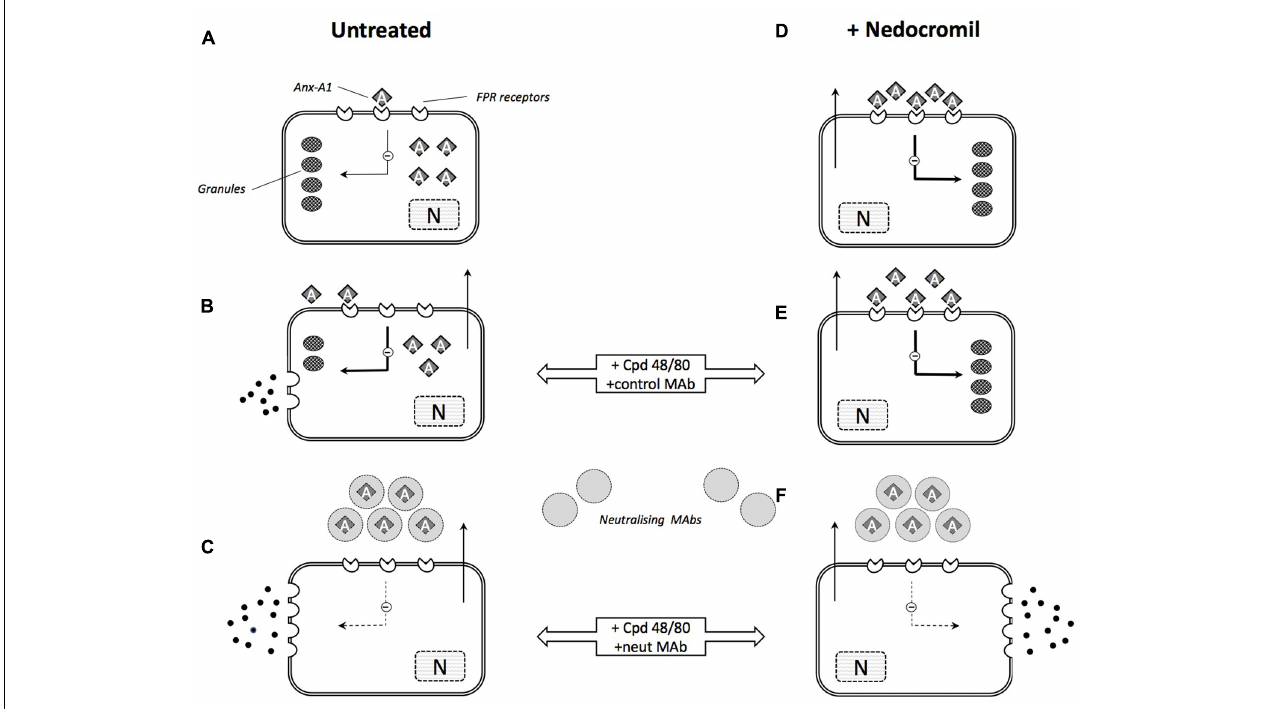
FIGURE 3 | Schematic illustration of the role of Anx-A1 in mast cell degranulation and cromone action. (A) In the untreated, ‘resting’ mast cell, there is an intracellular pool of Anx-A1, a small proportion of which is externalized exerting a low-level tonic inhibitory influence on cell activation. (B) During stimulation by (e.g., Cpd 48/80) granule contents are released but Anx-A1 is also phosphorylated and released as a result of PKC activation. This provides some feedback control over the extent of degranulation. (C) In the presence of neutralizing anti-Anx-A1 mAbs, this feedback control is lost and degranulation is more extensive. (D) In mast cells pre-treated with nedocromil or cromoglycate, Anx-A1 is already externalized and fully engaged with inhibitory FPR receptors. This suppresses degranulation in response to degranulating stimuli (E) by inhibiting the activation response and ‘stabilizing’ the mast cell. (F) In the presence of the neutralizing mAb, however, this inhibitory influence is removed and extensive degranulation